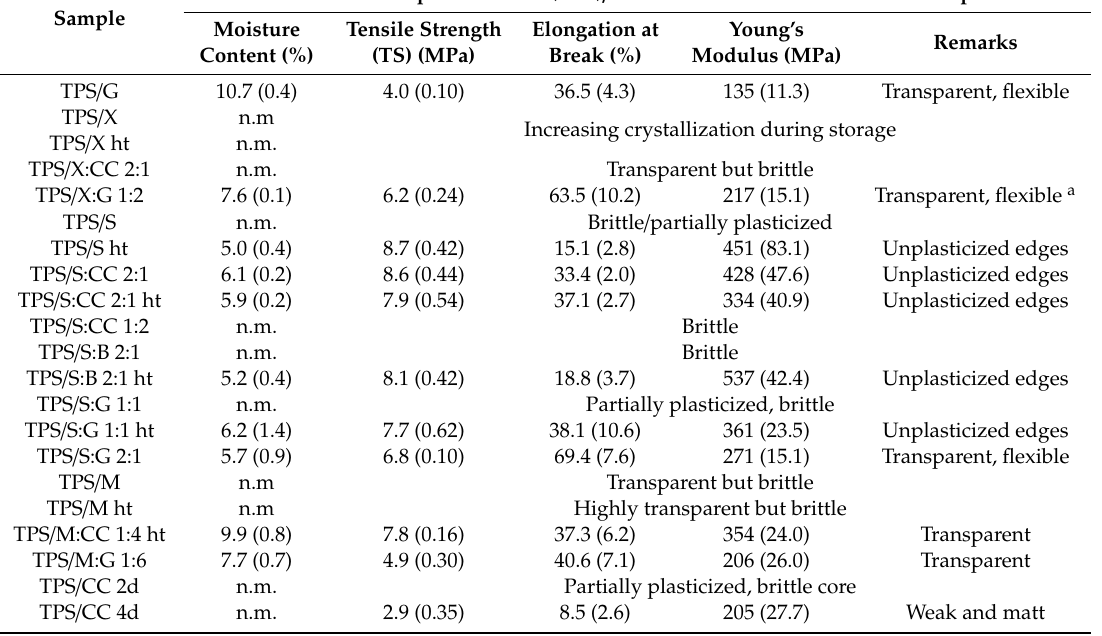
Table 4. Mechanical properties of thermoplasticized compositions (standard deviation values in the